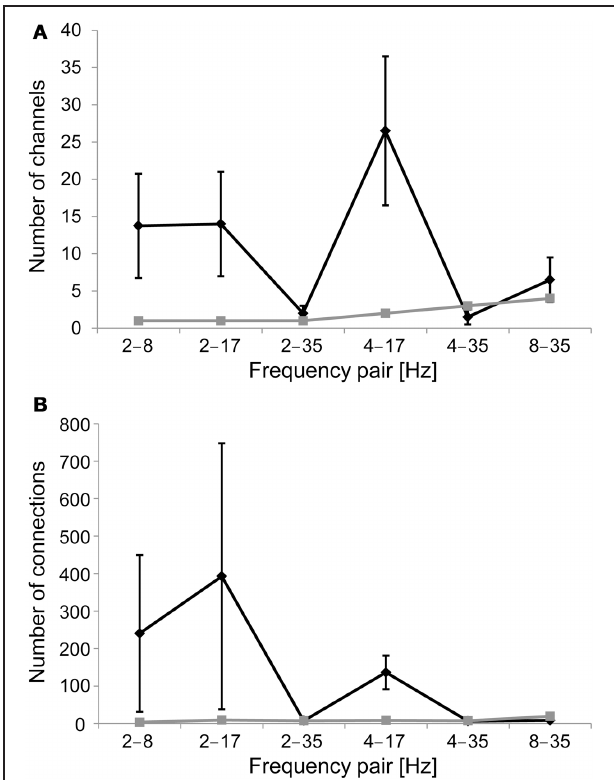
FIGURE 3 | (A) Number of channels that display significant nested oscillations (mean ± S.E.) in each frequency band pair. The black line is for the mean over subjects, and the gray line is for empty-room data. (B) As in (A) , but the number of channel pairs that display significant nested synchrony in each frequency band pair is